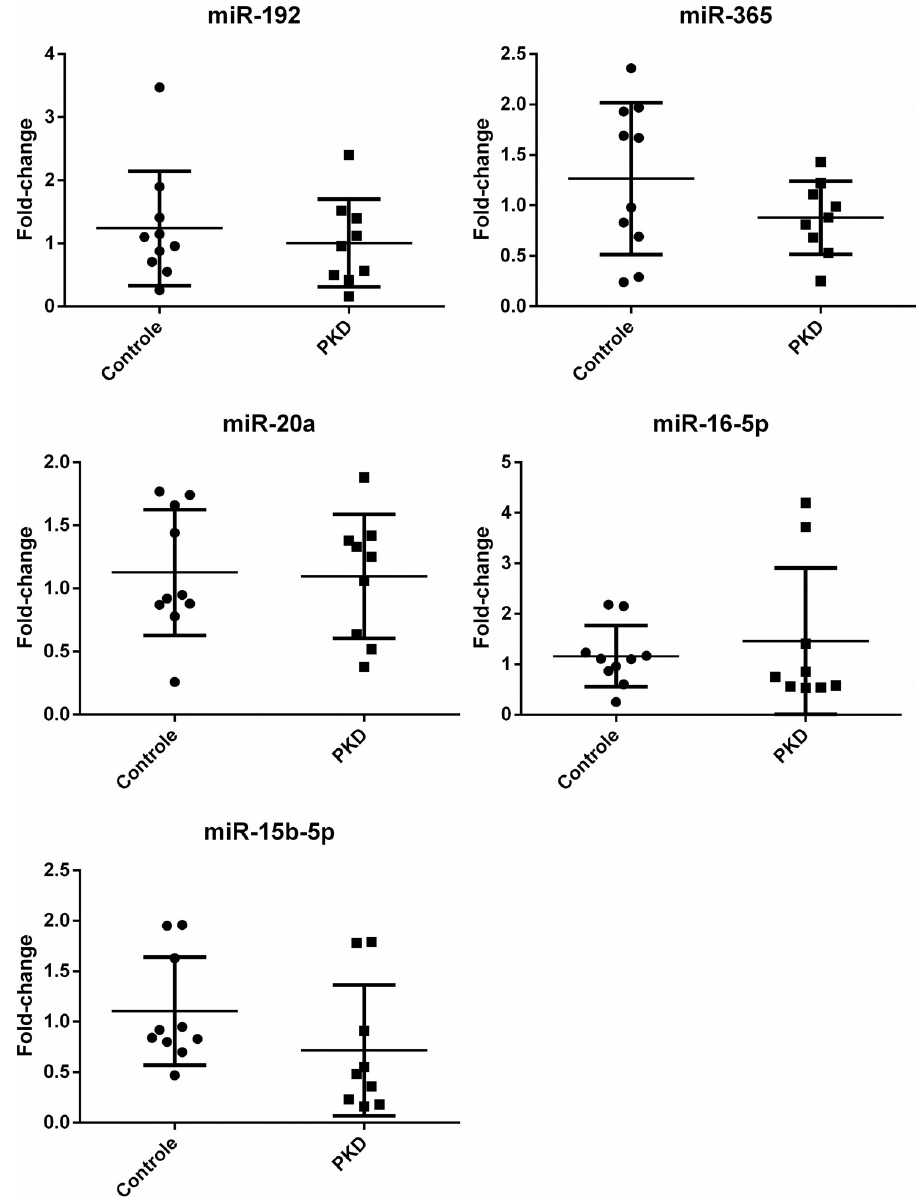
Fig 1. Fold change of plasma microRNAs (miR-20a, miR-192, miR-365, miR-16-5p, miR-15b5p) from domestic cat. RT-rtPCR assays. Normalized with cel-miR-39-3p (p > 0.05).